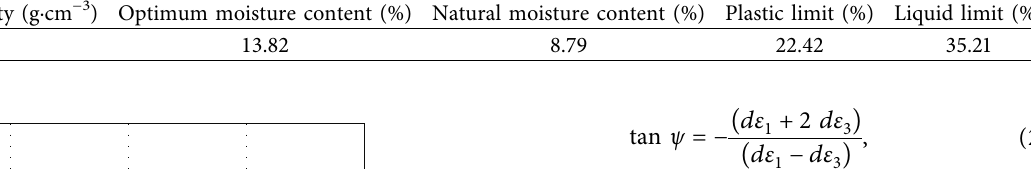
Table 1: Main physical properties of DCM.